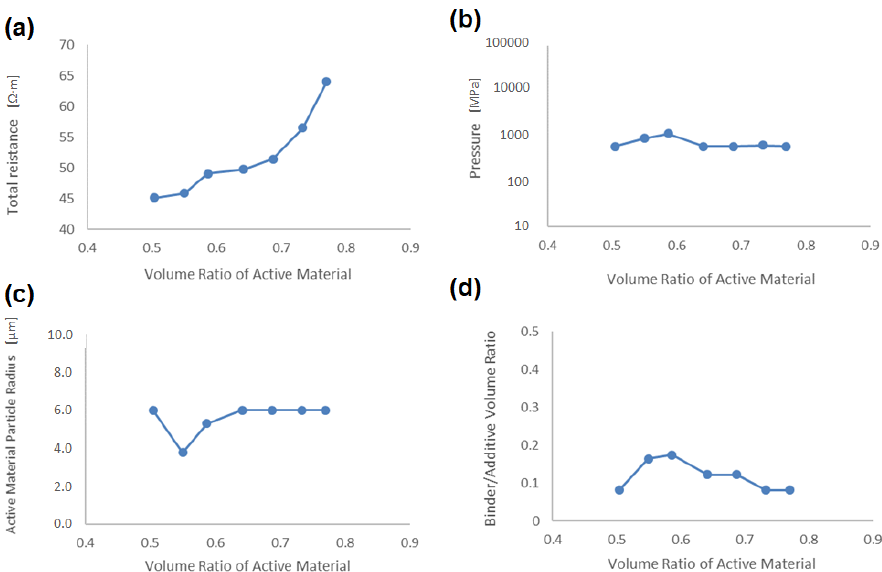
Figure 11. Dependence to the volume ratio in the active material of ( a ) total specific resistance, ( b ) pressure in the compaction process, ( c ) active material radius, and ( d ) binder/additives volume ratio.